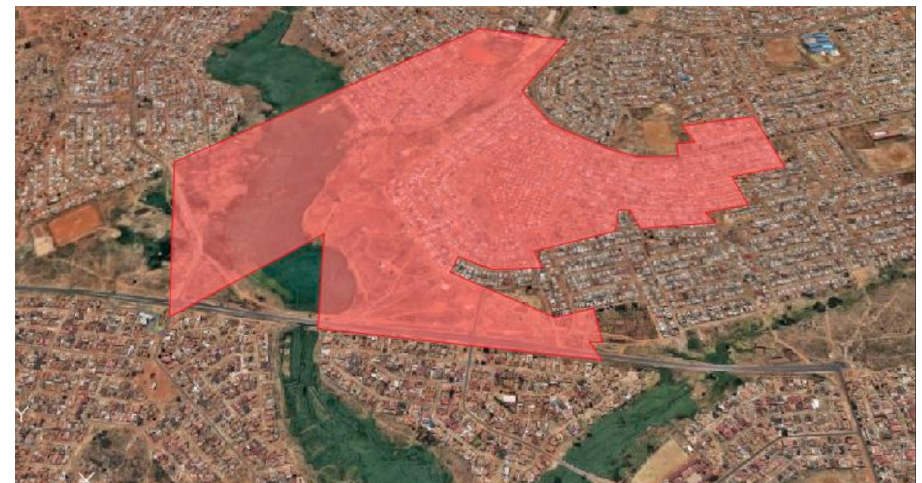
Figure 1. Map of Doornkop, Soweto.